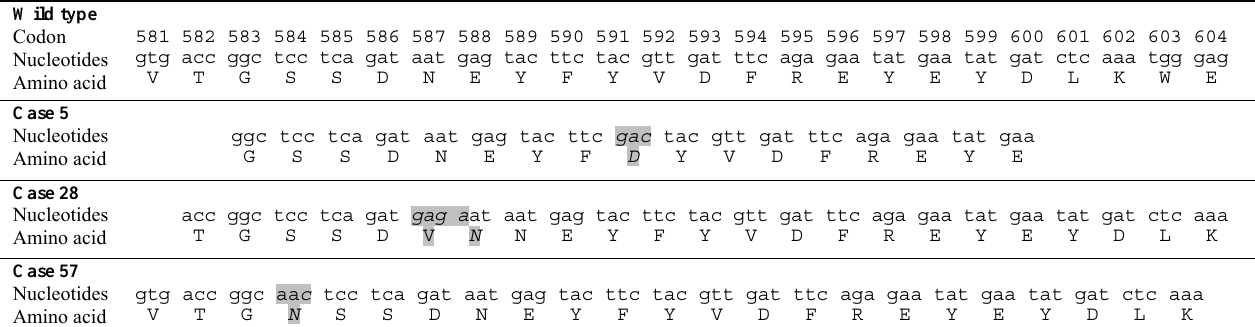
Figure 2. Sequence analysis of exons 14 and 15 of FLT3 gene. Inserted nucleotides for tandem duplications of the Flt3 gene observed in AML cases with apparent CSGE patterns.